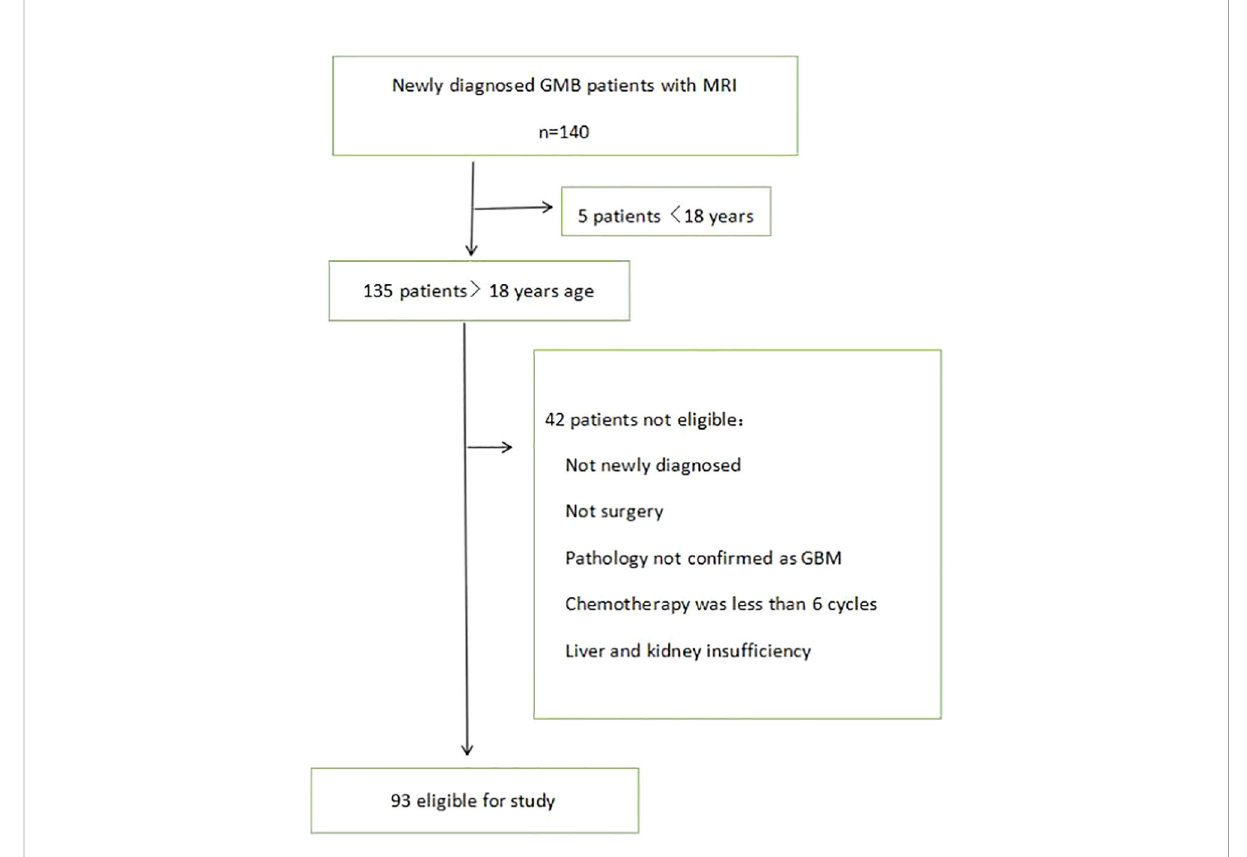
FIGURE 1 Patient identi fi cation and